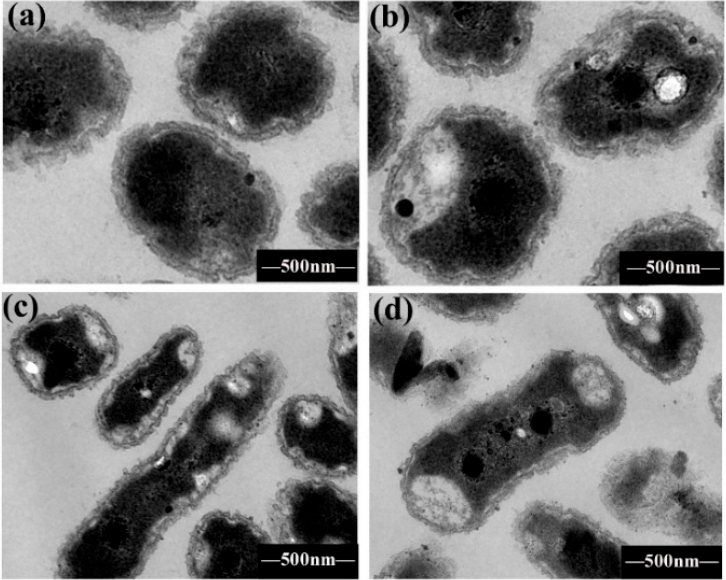
Figure 3. TEM images of R. solanacearum cells treated with ( a ) DMSO; ( b ) umbelliferone; ( c ) esculetin; and ( d ) daphnetin, respectively. Overnight cultured bacterial suspension was diluted into B medium supplemented with coumarins (50 mg/L umbelliferone, 50 mg/L esculetin and 25 mg/L daphnetin) and incubated at 30 °C for 12 h.